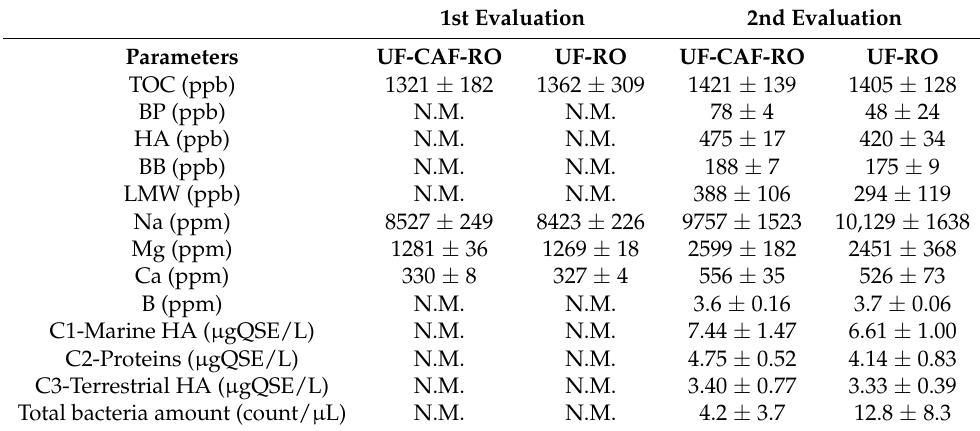
Table 1. Water quality of RO feed water for UF-CAF-RO and